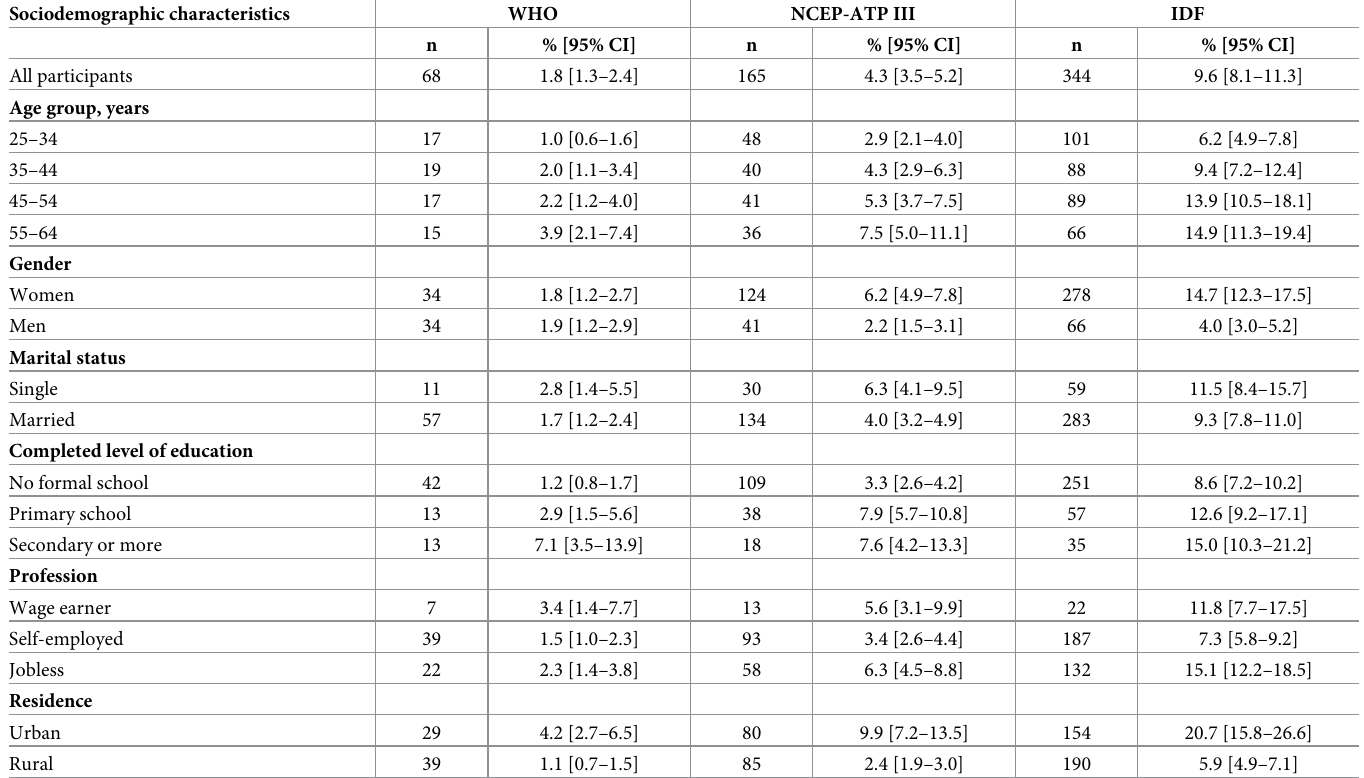
Table 4. Prevalence of metabolic syndrome according to each of six definitions by sociodemographic characteristics. Sociodemographic